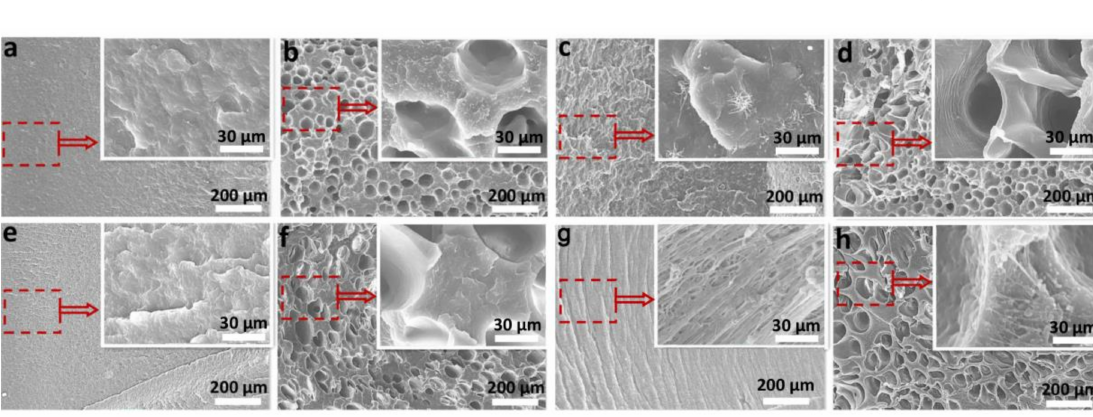
Figure 7. The impact section structures of PP composites, inset with the partial enlargement: ( a ) unfoamed PP/TPR-5 wt %, ( b ) foamed PP/TPR-5 wt %, ( c ) unfoamed PP/TPR-20 wt %, ( d ) foamed PP/TPR-20 wt %, ( e ) unfoamed PP/POE-5 wt %, ( f ) foamed PP/POE-5 wt %, ( g ) unfoamed PP/POE-20 wt %, ( h ) foamed PP/POE-20 wt %.